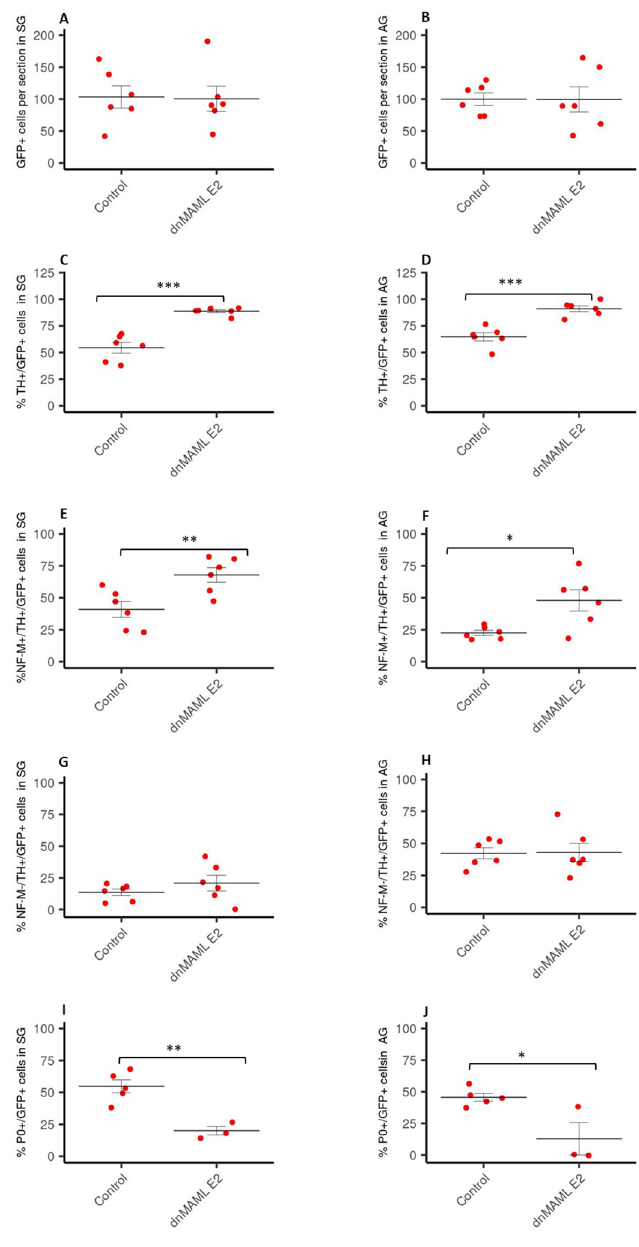
Fig 4. Quantification of cells expressing various markers in SG and AG following electroporation with dnMAML at E2. Number of GFP-positive cells per section (% of control) in sympathetic ganglia (SG) (A) and the adrenal gland (AG) (B) of E6 chick embryos after electroporation with dnMAML at E2 and immediate tet-on activation expressed as percentage of control experiments. Percentage of TH-positive cells out of GFP-positive cells counted in SG (C) and AG (D) of E6 chick embryos after electroporation with dnMAML at E2 and immediate tet-on activation (control n = 6, dnMAML = 6). Amount of NF-M+/TH+/GFP+ (E, F) and NF-M-/TH+/GFP+ (G, H) in SG (E, G) and AG (F, H) of E6 chick embryos after electroporation with dnMAML at E2 and immediate tet-on activation (control n = 6, dnMAML n = 6). Data are expressed as percentage of the total number of GFP-positive cells. Percentage of P0-positive cells out of GFP-positive cells in SG (I) and AG (J) of E6 chick embryos after electroporation with dnMAML at E2 and immediate tet-on activation (control n = 4–5, MAML = 3–4). Data are presented s mean +/- S.EM. � p � 0.05; �� p � 0,01; ��� p � 0,001; n: number of experimental animals. The values used to build the graphs in S3 File.